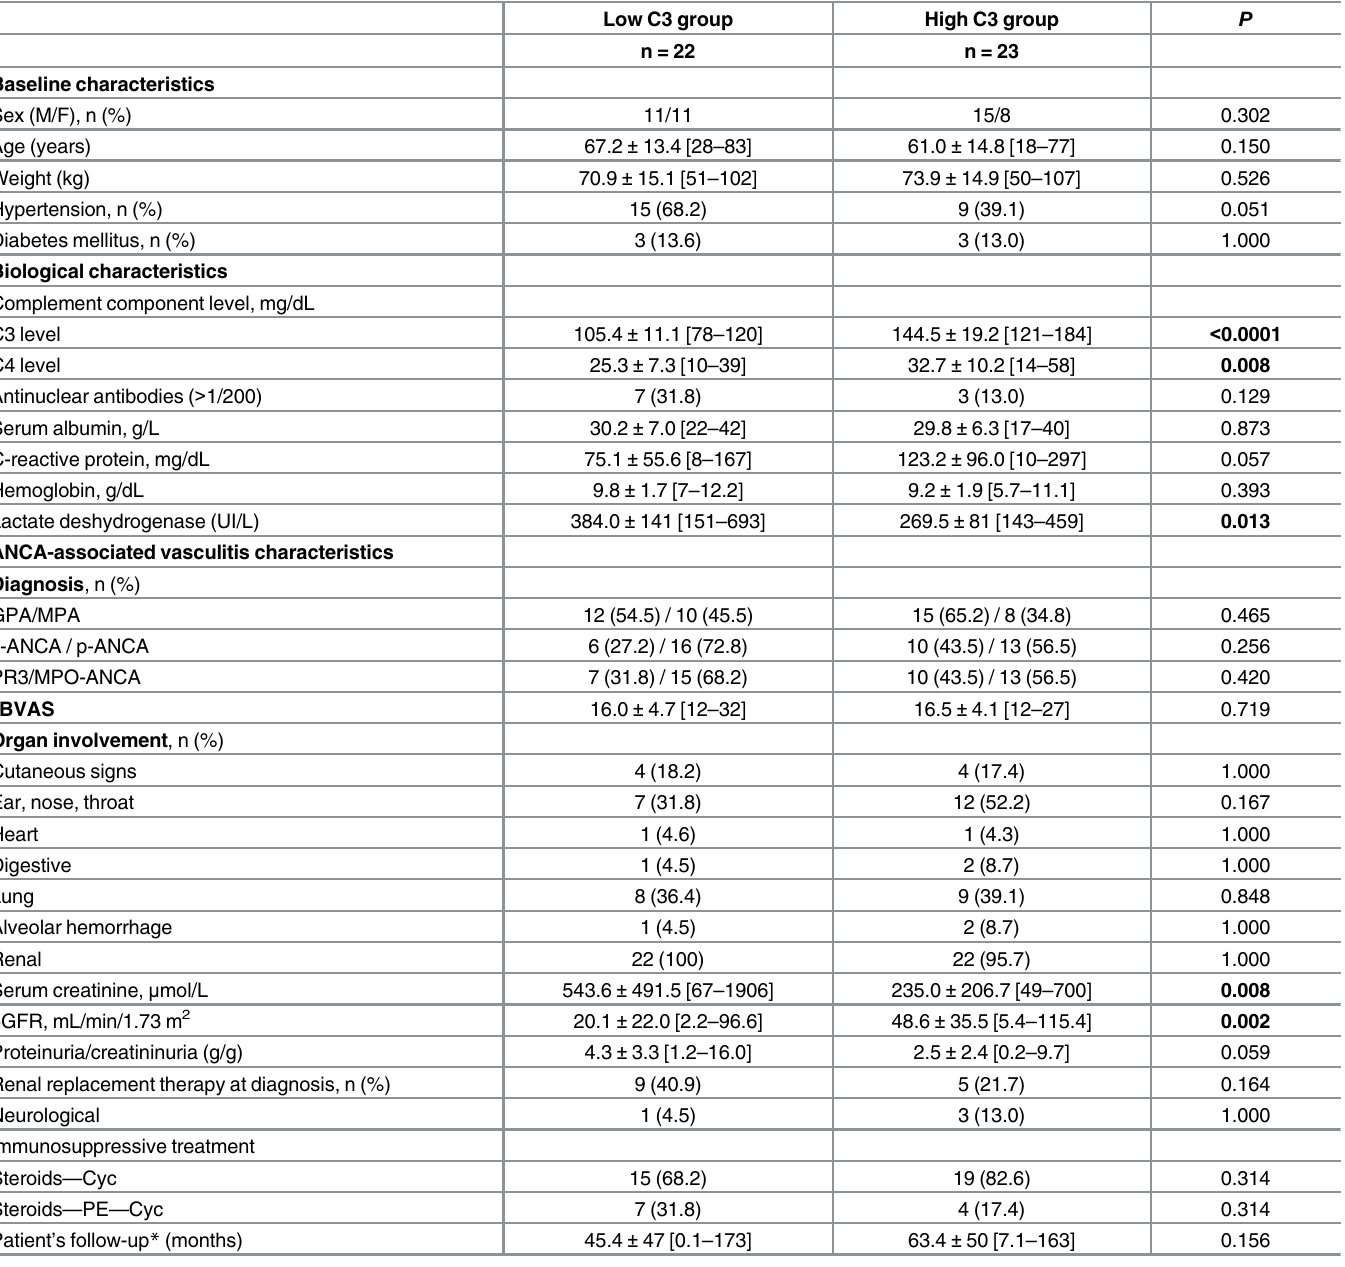
Table 2. Comparison of clinical and biological features according to serum C3